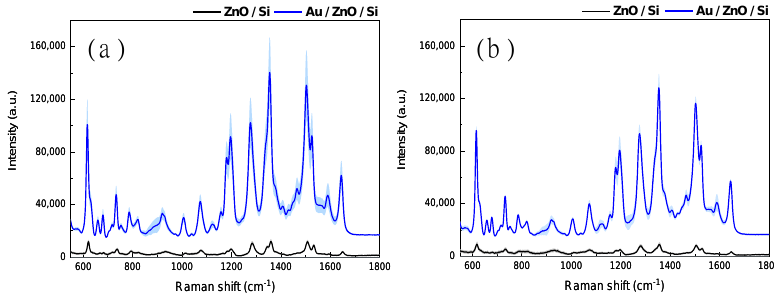
Figure 6. Raman spectra for rhodamine B on ZnO nanostructures. ( a ) Spin-seeded ZnO nanorods. ( b ) Sputter-seeded ZnO nanorods. Each panel shows the illumination-corrected comparative spectra for the SERS e ff ect of (black curve) Rh B on ZnO nanorods and (blue curve) rhodamine B (RhB) on ZnO nanorods deposited with 200 nm gold. Dark lines indicate average signal, while pastel regions indicate one standard deviation of measurement variance.